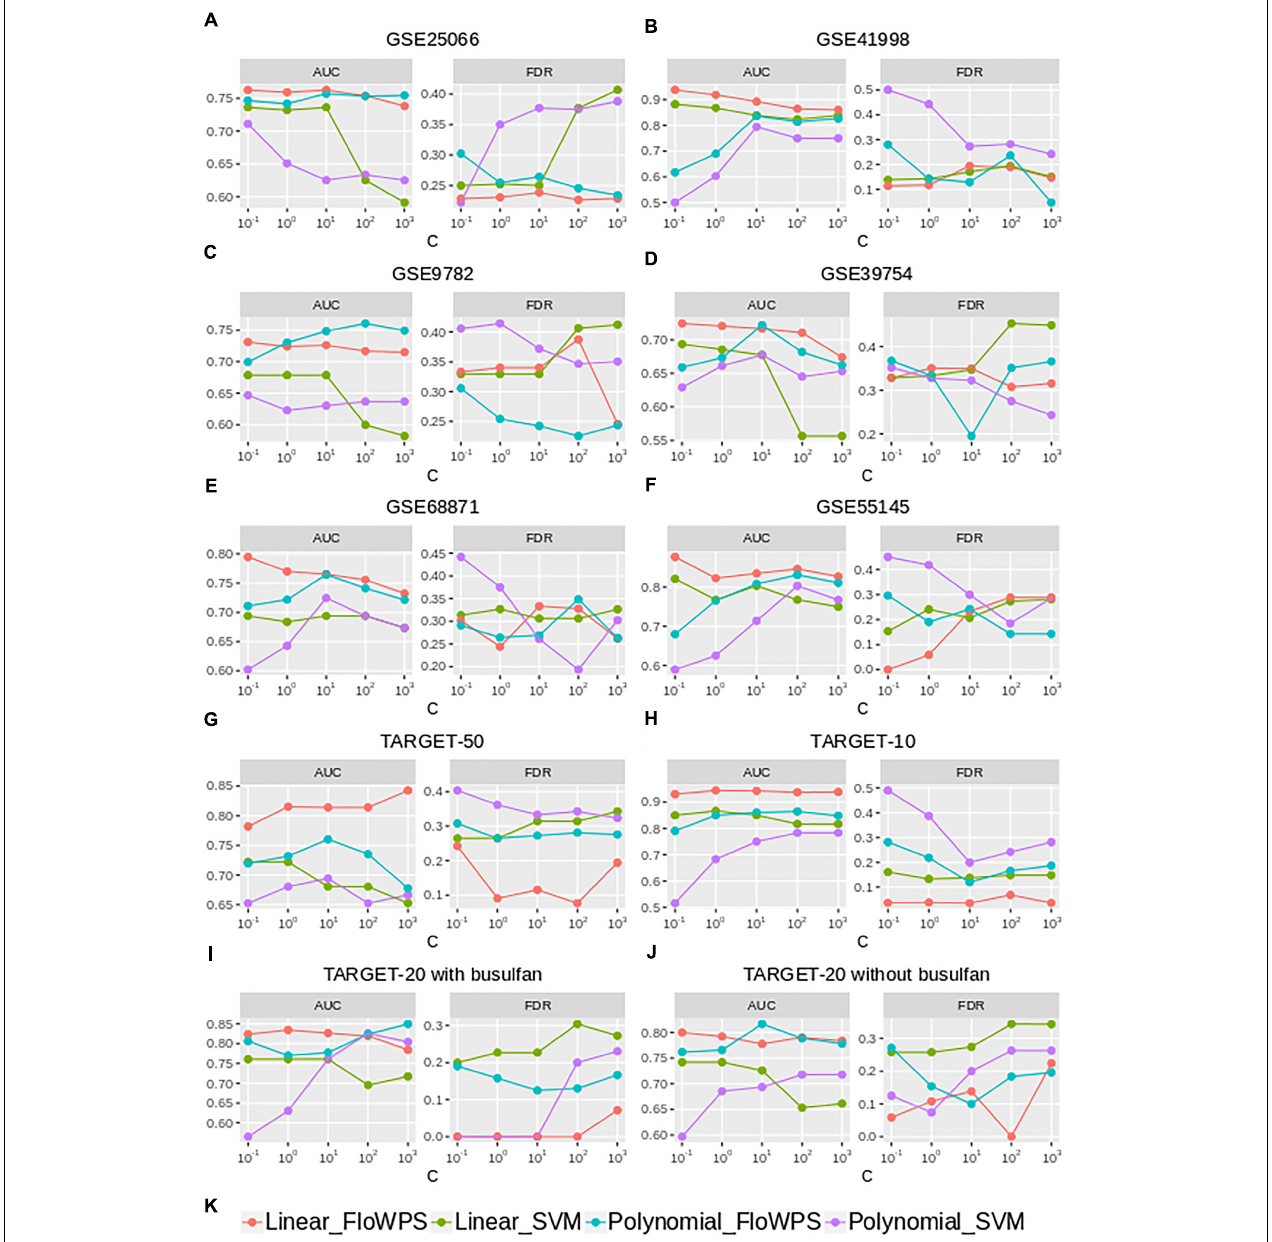
FIGURE 5 | AUC and FDR for (non)responders classifier as a function of cost/penalty parameter C for classical SVM (without data trimming) and FloWPS for both linear and polynomial kernels. Calculations were done for core marker gene datasets and confidence parameter p = 0.90. Different panels represent different datasets, (A) GSE25066; (B) GSE41998; (C) GSE9782; (D) GSE39754; (E) GSE68871; (F) GSE55134; (G) TARGET-50; (H) TARGET-10; (I,J) TARGET-20 with and without busulfan and cyclophosphamide, respectively. (K) Legend showing FloWPS and SVM